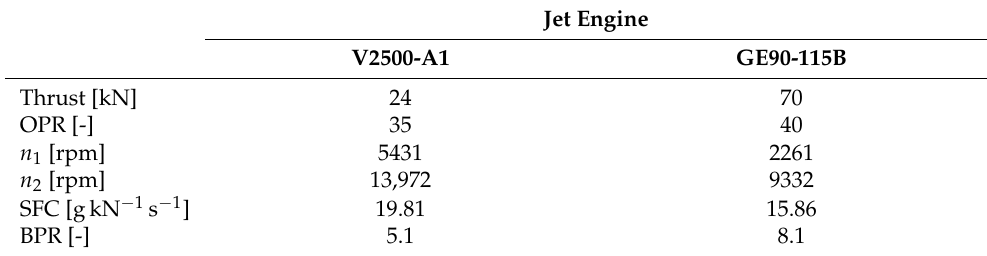
Table 1. On-design operating points considered in this study for each jet